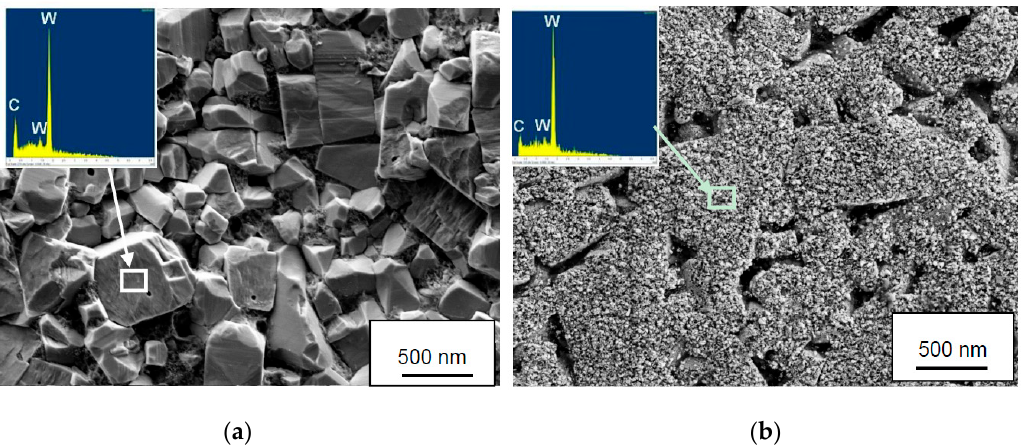
Figure 5. Surface characteristics of worn cemented carbide in the crater wear region as observed after removing the adhered work material by wet etching and energy dispersive X-ray spectroscopy (EDS) analysis obtained from the indicated areas. ( a ) Rough worn surface morphology due to attrition wear observed at low cutting speed and ( b ) smooth worn surface morphology due to diffusion wear observed at high cutting speed. Note the fine nanometer scale surface morphology of the surface in ( b ).